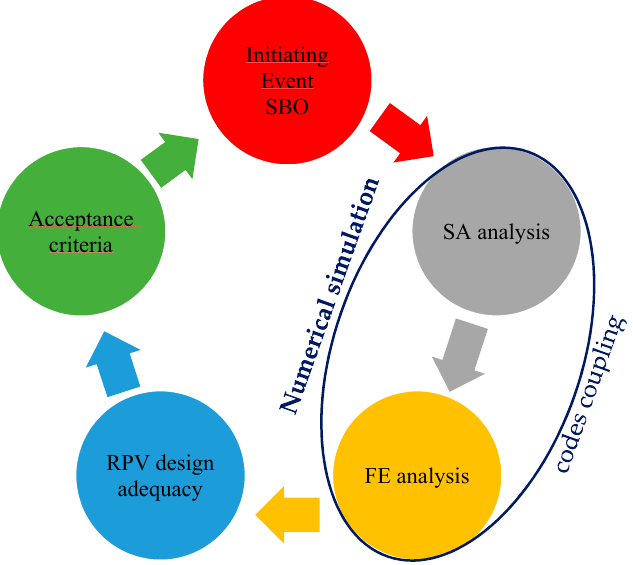
Figure 3. Phases of the developed methodology for the assessment of ageing effects.